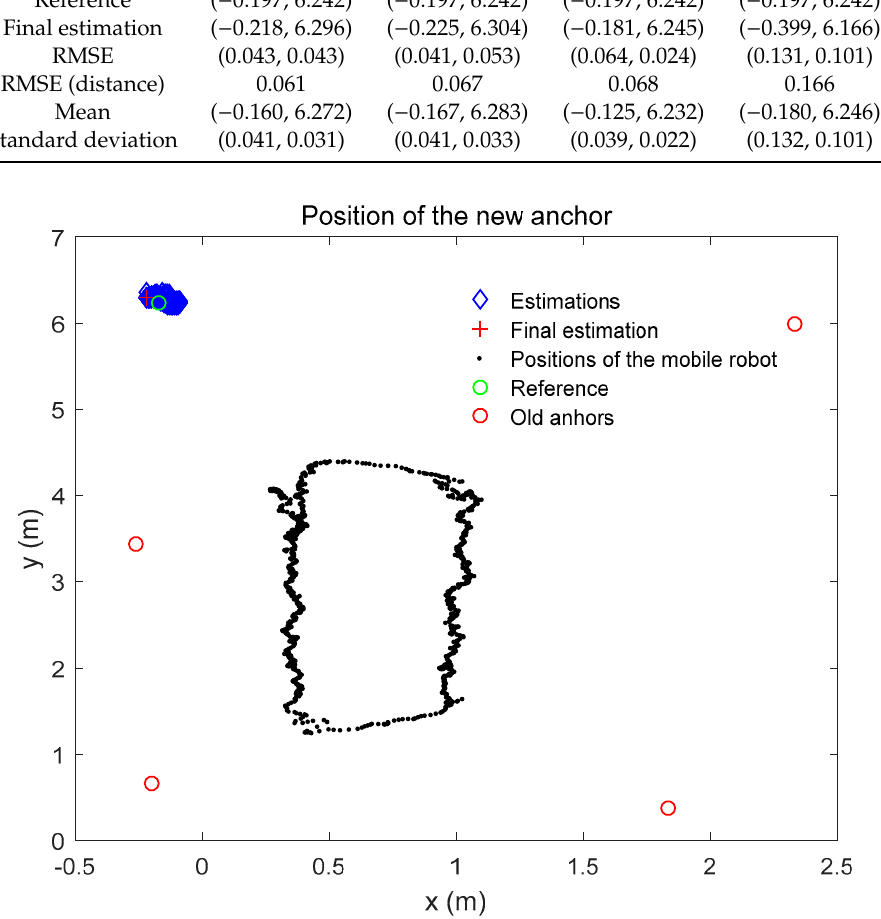
Figure 8. Positioning of the new anchor.